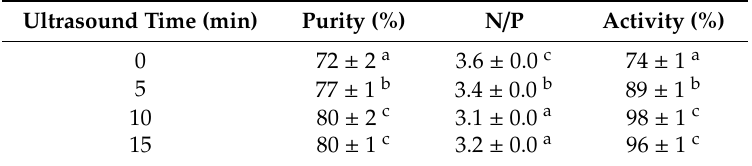
Table 3. E ff ect of ultrasound time (min) on purity, N / P and activity of Pv. Ultrasound Time